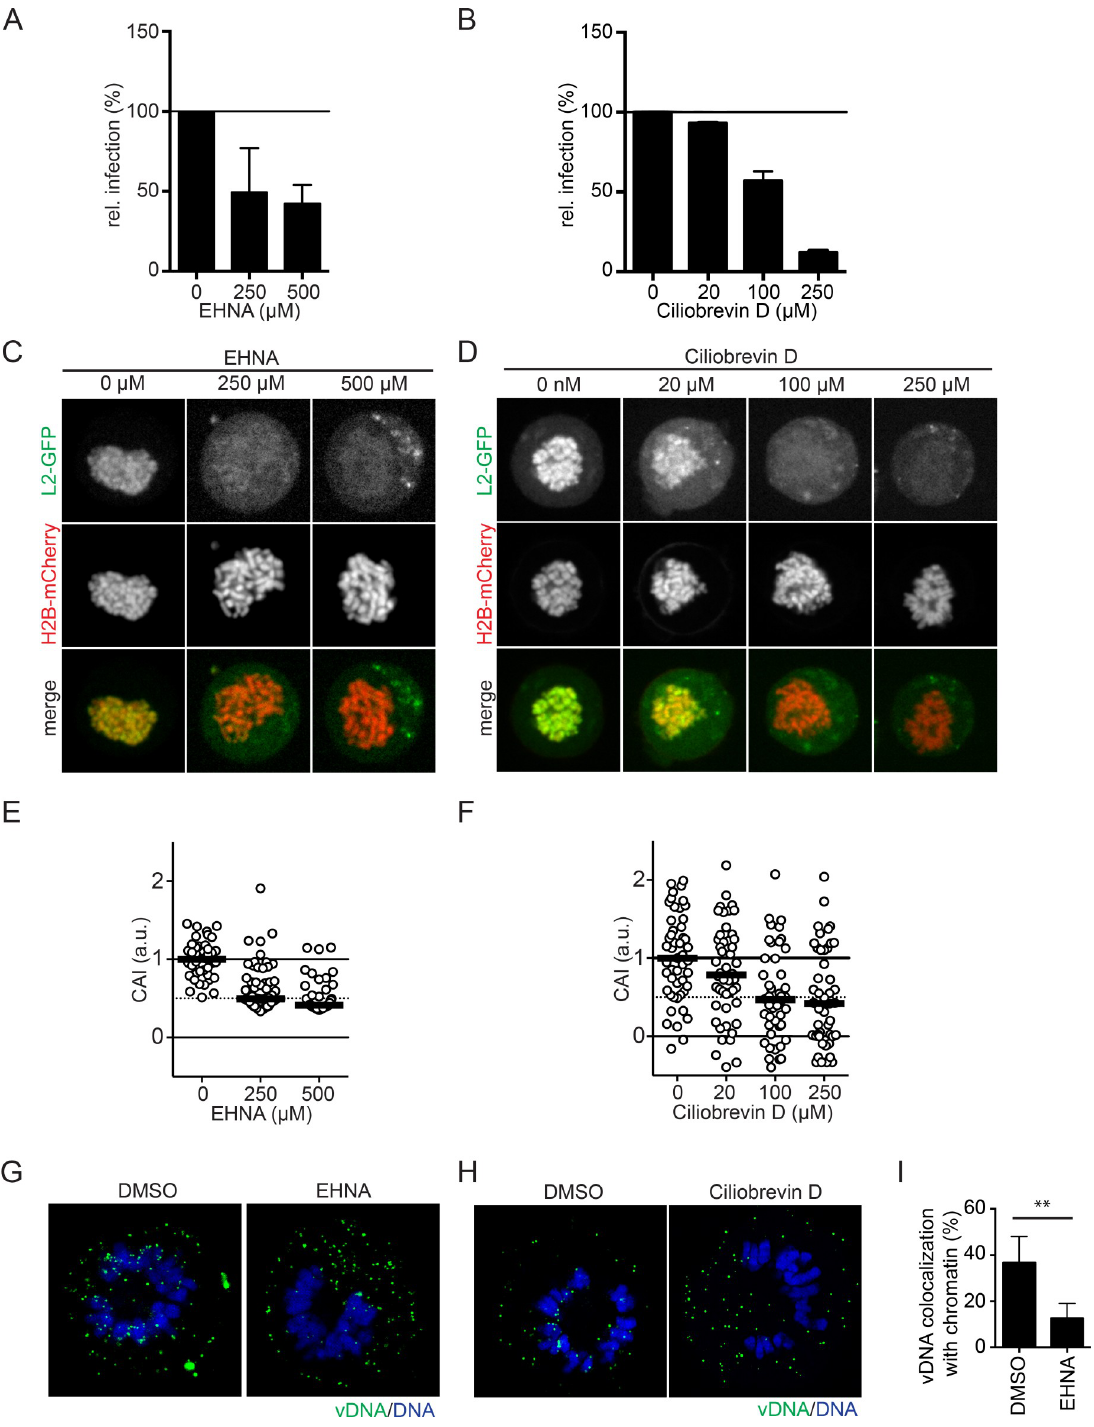
Fig 6. Dynein function was crucial for HPV16 infection and L2 tethering. EHNA or ciliobrevin D was used to inhibit dynein-mediated transport. HeLa Kyoto cells were treated with EHNA (A) or ciliobrevin D (B) one hour prior to and during HPV16 infection. The infectivity was scored based on the percentage of the cells expressing GFP with flow cytometry. The infectivity was normalized to DMSO- treated cells as relative infection. (C)(D) HeLa Kyoto_H2B-mCherry_L2-GFP cells were treated with EHNA (C) or ciliobrevin D (D) and nocodazole (330 nM) for 16 hours. L2 chromosomal association assay was assessed as described in Fig 2B. Depicted are single confocal slices. (E) and (F) : Quantification of (C) and (D), respectively. The CAI was normalized and analyzed as in Fig 2C. At least 40 cells were